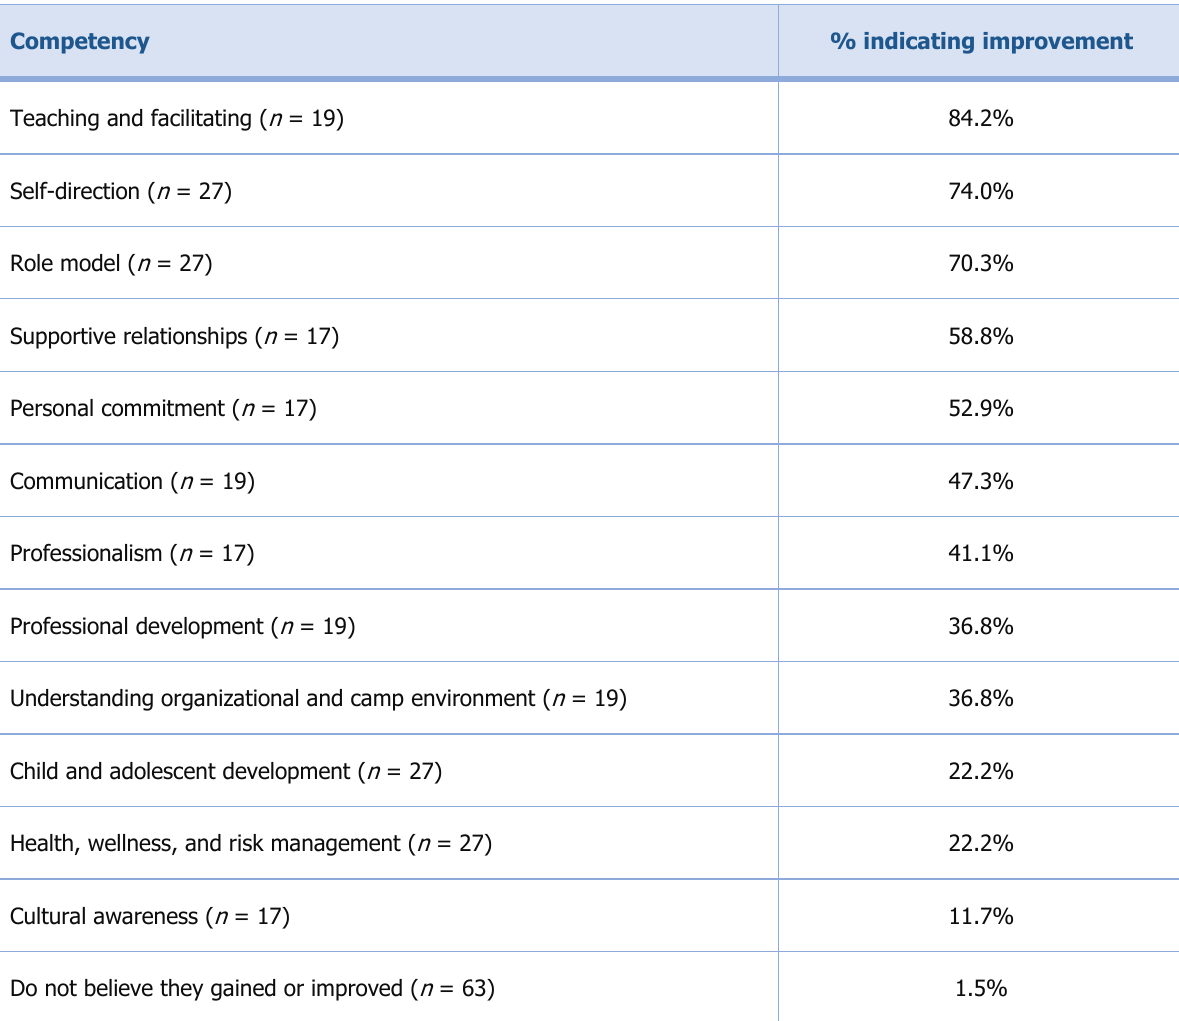
Table 8. 4- H Professionals’ Belief About Camp Counselor Skills Gained or